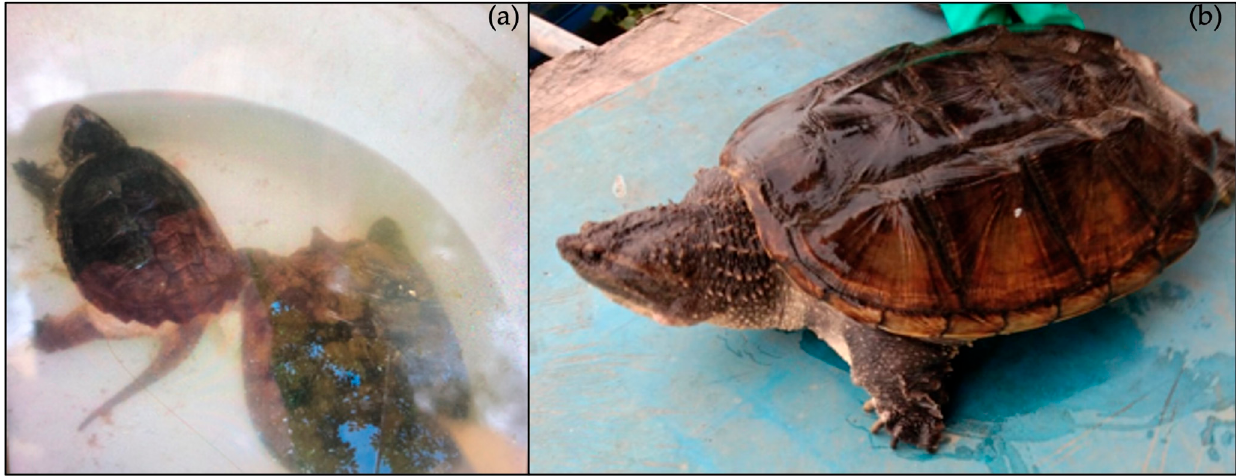
Figure 3. First record of the invasive Common snapping turtle , Chelydra serpentina : ( a ) sub-adult individual caught together with a Pelodiscus sinensis in Luc Nam River—Luc Nam, Bac Giang province; ( b ) 5-kg individual from Red River—Hung Ha, Thai Binh province.